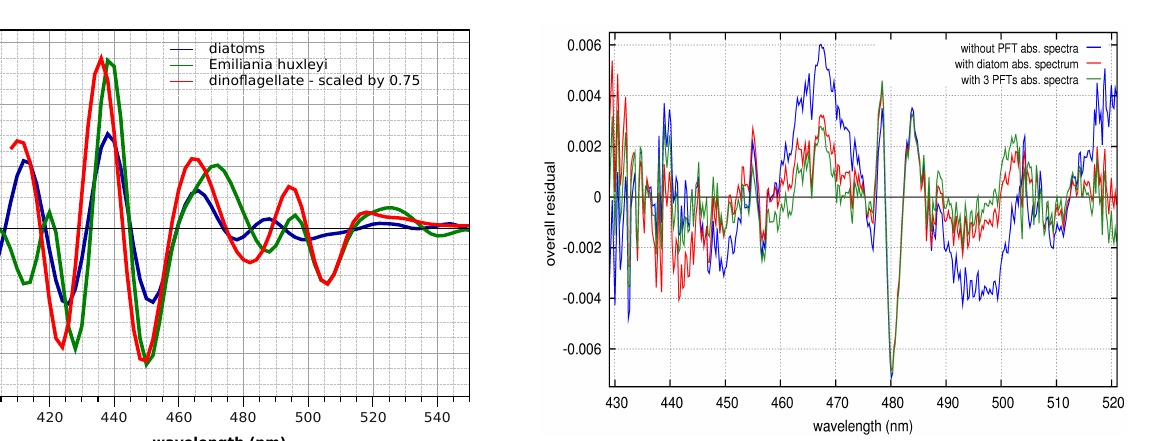
Fig. 4. The improvement to PhytoDOAS was performed by a si- multaneous fit of the absorption spectra of selected phytoplankton targets in an appropriate wavelength window. This figure compares the overall residuals of the PhytoDOAS retrievals in three differ- ent fit-modes: without any PFT target (blue), only with the diatoms abs. spectrum (red) and with the abs. spectra of three selected PFTs (green). All three residual spectra have been obtained via consecu- tive runs of DOAS for the same SCIAMACHY orbit, passing over North Atlantic (the first of July 2005). A sample ground-pixel of this orbit has been taken to plot the residuals, which corresponds to the pixel-center located at 54 . 51 ◦ N and 21 . 47 ◦ W . 3